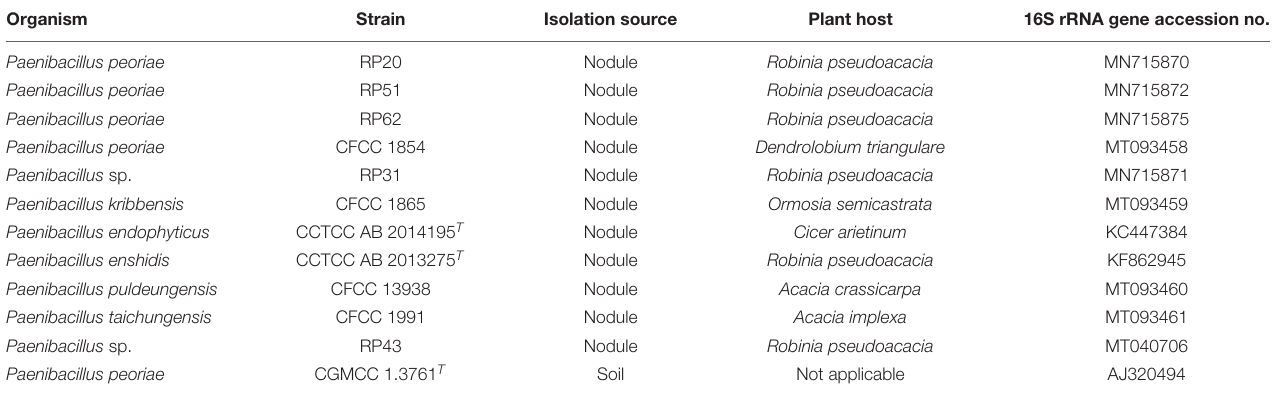
TABLE 1 | Paenibacillus strains used in this